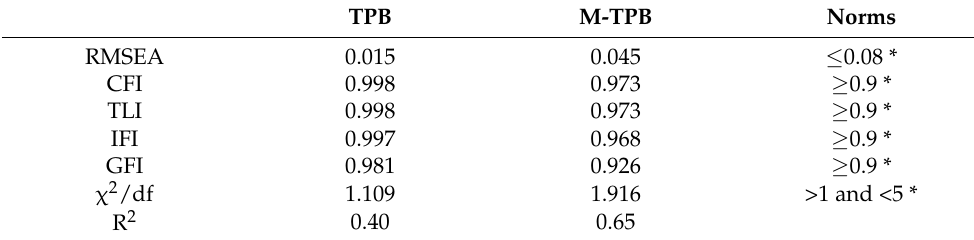
Table 5. Goodness of fit indices and explanatory power of two